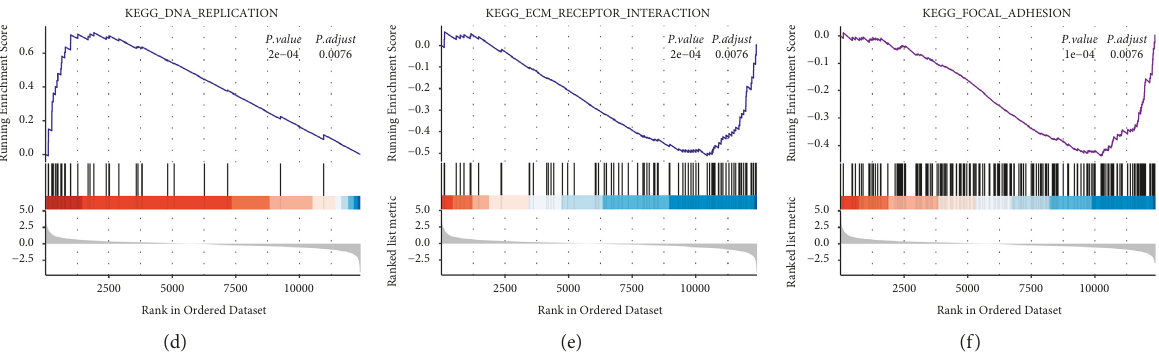
Figure 6: GSEA enrichment analysis of the gene set in the KEGG pathway. The gene profiles of samples were significantly enriched in the (a) cell cycle, (b) chemokine signaling pathway, (c) cytokine receptor interaction, (d) DNA replication, (e) ECM receptor interaction, and (f) focal adhesion. GSEA, gene set enrichment analysis; KEGG, Kyoto Encyclopedia of Genes and